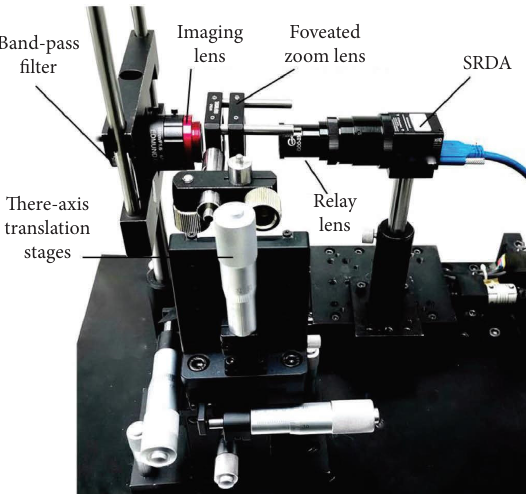
Figure 6: Foveated-zoom snapshot hyperspectral imaging system experimental setup.